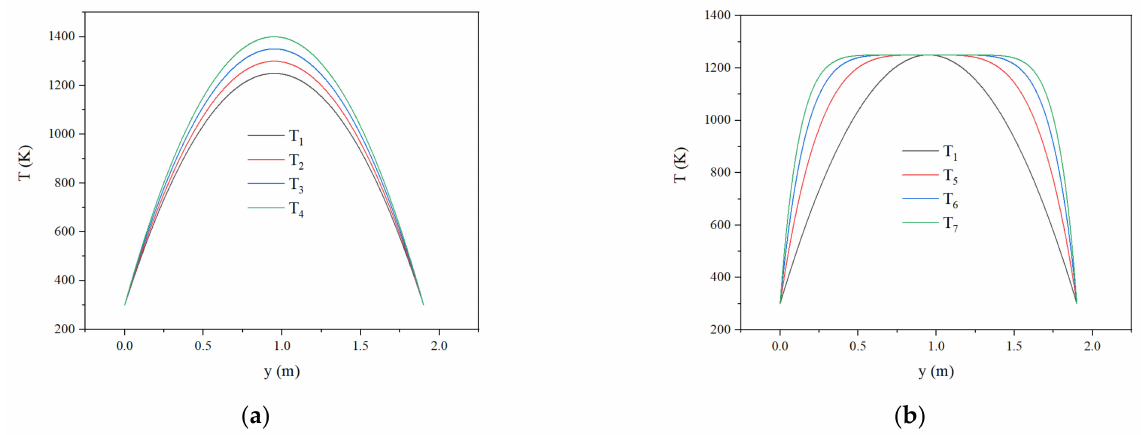
Figure 20. Initial temperature fields comparison. ( a ) T A ( y ); ( b ) T B ( y